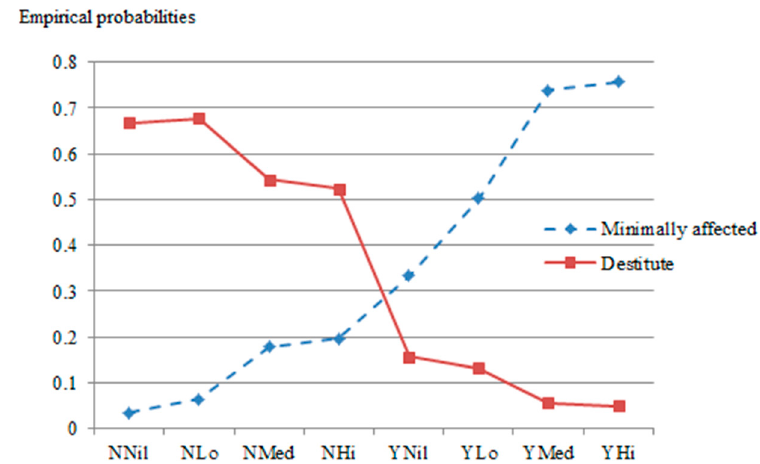
Figure 5. Contrasting financial risk as function of status of residency (N/Y) and actual insurance cover (nil/low/med/high). N—non-resident; Y—resident; Nil—uninsured; Lo—low insurance cover (low insurance reimbursement), Med—medium insurance cover (medium insurance reimbursement); Hi—high insurance cover (high insurance